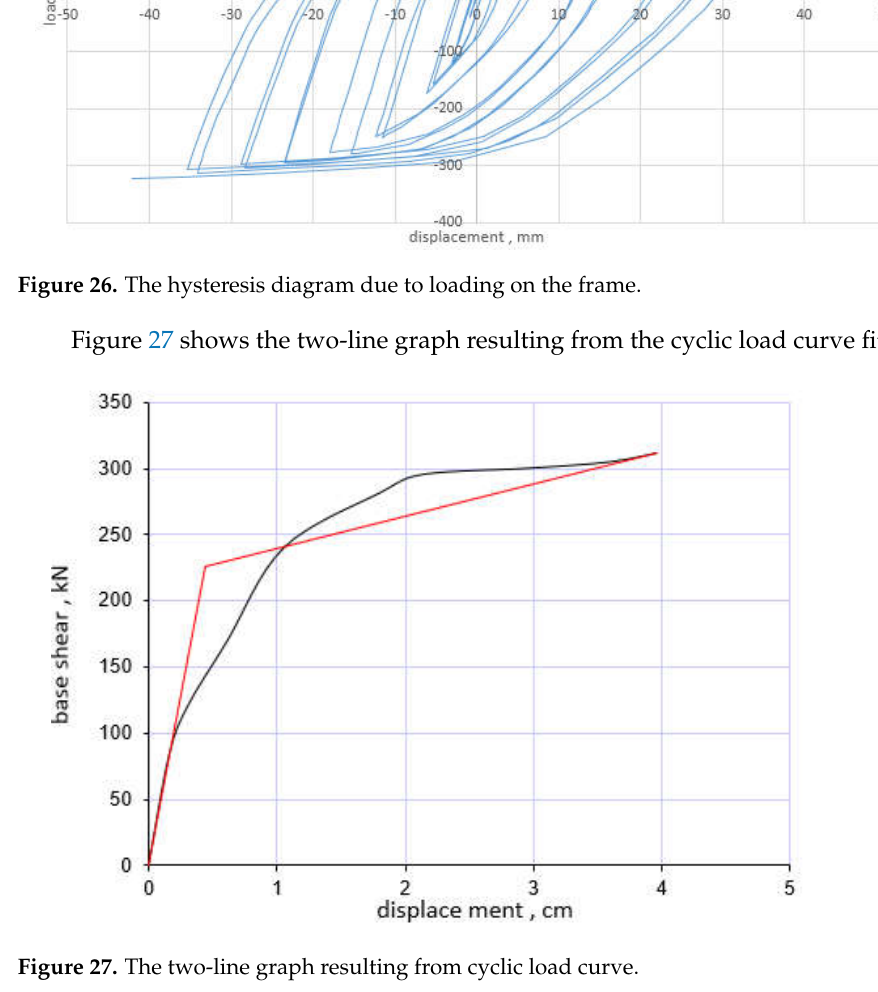
Figure 27. The two-line graph resulting from cyclic load curve. As can be seen in Figure 27, in this sample, as well as the previous two samples, the bilinear behaviour resulting from the hysteresis graph overlay, the separation between the curve and the first line occurs with a greater distance than in other samples, and the reason for this is the noticeable difficulty control. Lateral by the damper member and its increase in the structure. In this sample, the slope of the second line is approximately 4.6% of the slope of the curve in the first part, which is similar to the previous sample. This problem shows the improvement of nonlinear behaviour due to the increase in the thickness of the plate web in the damper. The initial stiffness change from 3800 kN/cm of the single sample to 525 kN/cm in the sample connected to the frame shows the influence of the frame characteristics on the behaviour of the damper in this case. Examining the ductility of the structure indicates that, in this case, the ductility is greatly reduced. Table 6 shows the characteristics resulting from the pushover curve of this